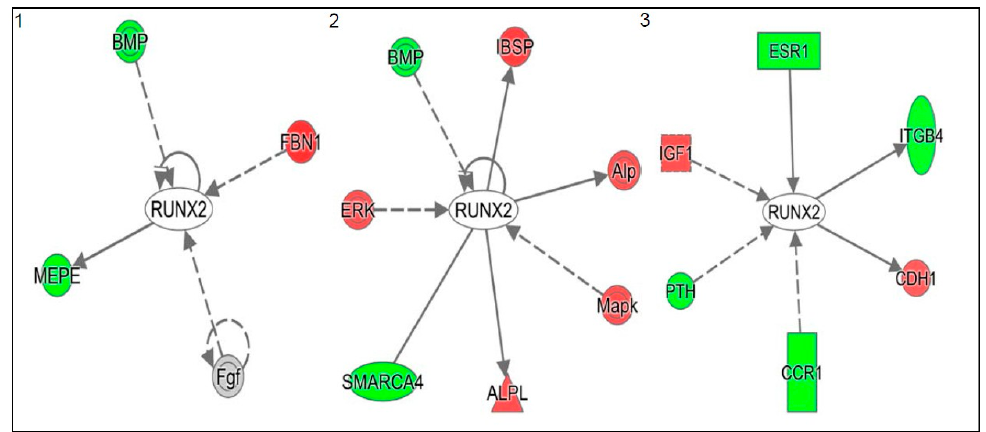
Figure 3. Vitamin D–Runx2 interactome reveals key genes that represent potential disease and therapeutic biomarkers in 143B human OS cells. Numbers 1–3 represents different growth stages of 143B cells post vitamin D treatment vs. control (ethanol or vehicle treated), namely proliferation, three days; post proliferation, nine days; and differentiation, 14 days. The colors red and green indicate genes that are up and down regulated, respectively. Solid lines imply direct interaction while dotted lines represent indirect interaction.